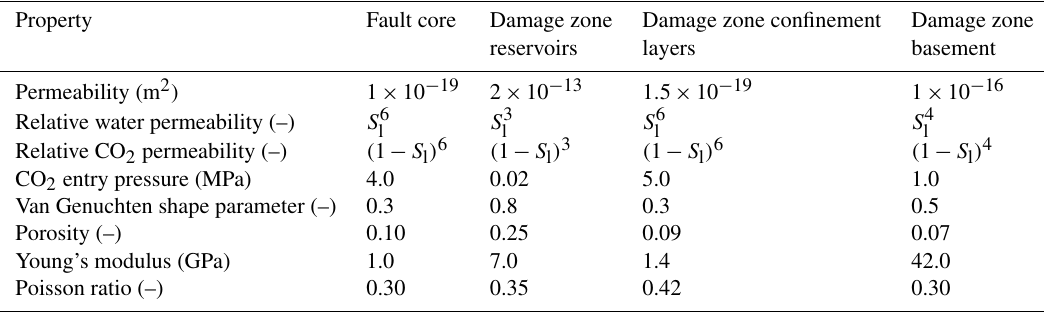
Table A2. Properties of the materials forming the fault of the model shown in Figs. 6 and 7.